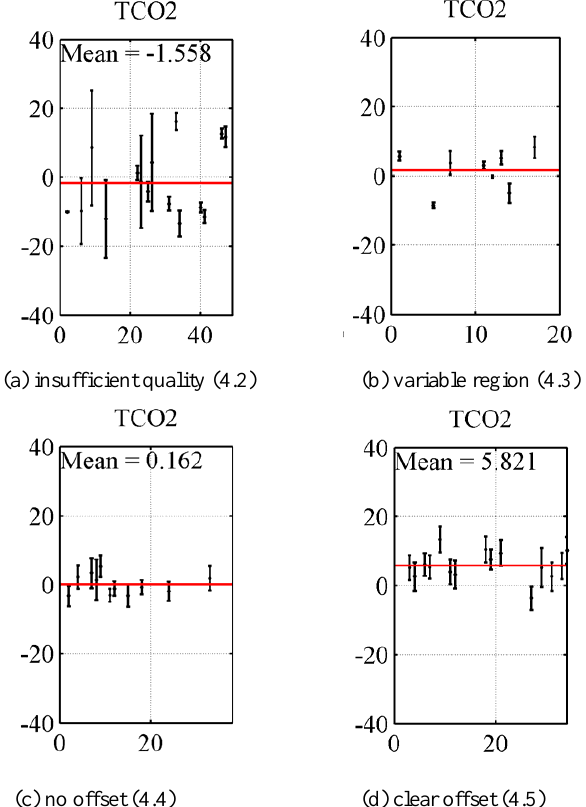
Figure 6. Example of plots of all offsets for one cruise and their standard deviation as a vertical bar versus cruise number. The standard deviation is the deviation of the mean of all points below 1500 m used for the particular crossover comparison. Each plot is representative of a type of cross-over analysis result described in section 4: (a) data is of insufficient quality or from variable regions, based on the large standard deviation, to estimate an adjustment, (b) the geographical region where the cruise took place is known to experience too much variability to suggest an adjustment, (c) The cross-over offset was well below the 4 µmol kg -1 cutoff and no adjustment is recommended and (d) the cross-over analysis showed a large and consistent offset with other cruises and an adjustment was applied.